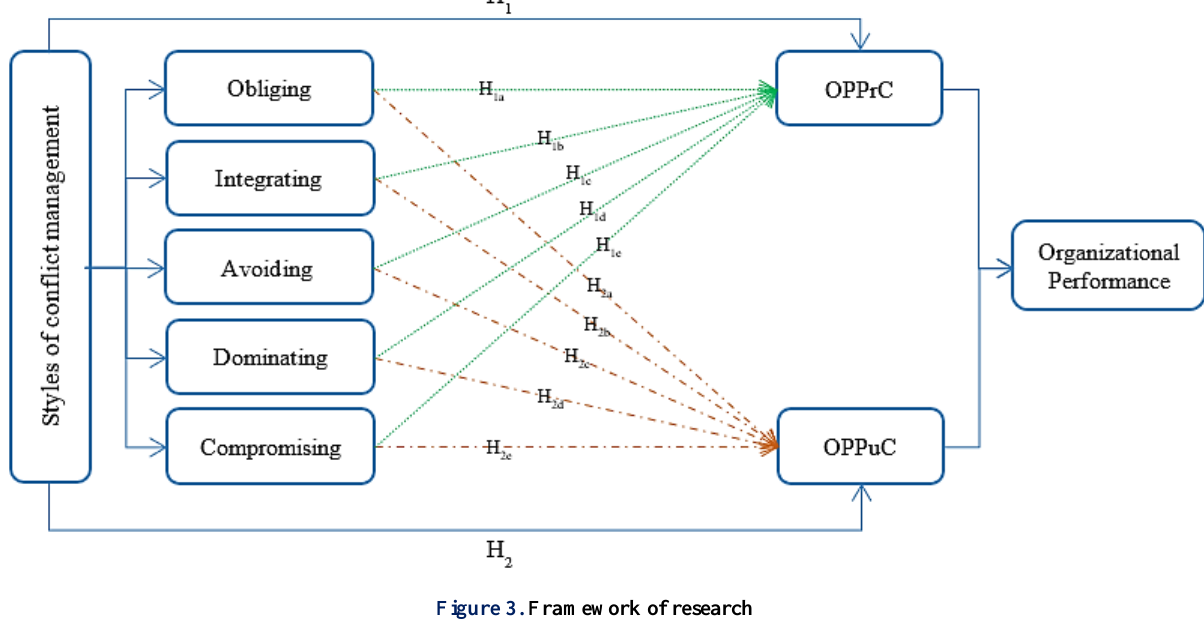
Figure 3. Framework of